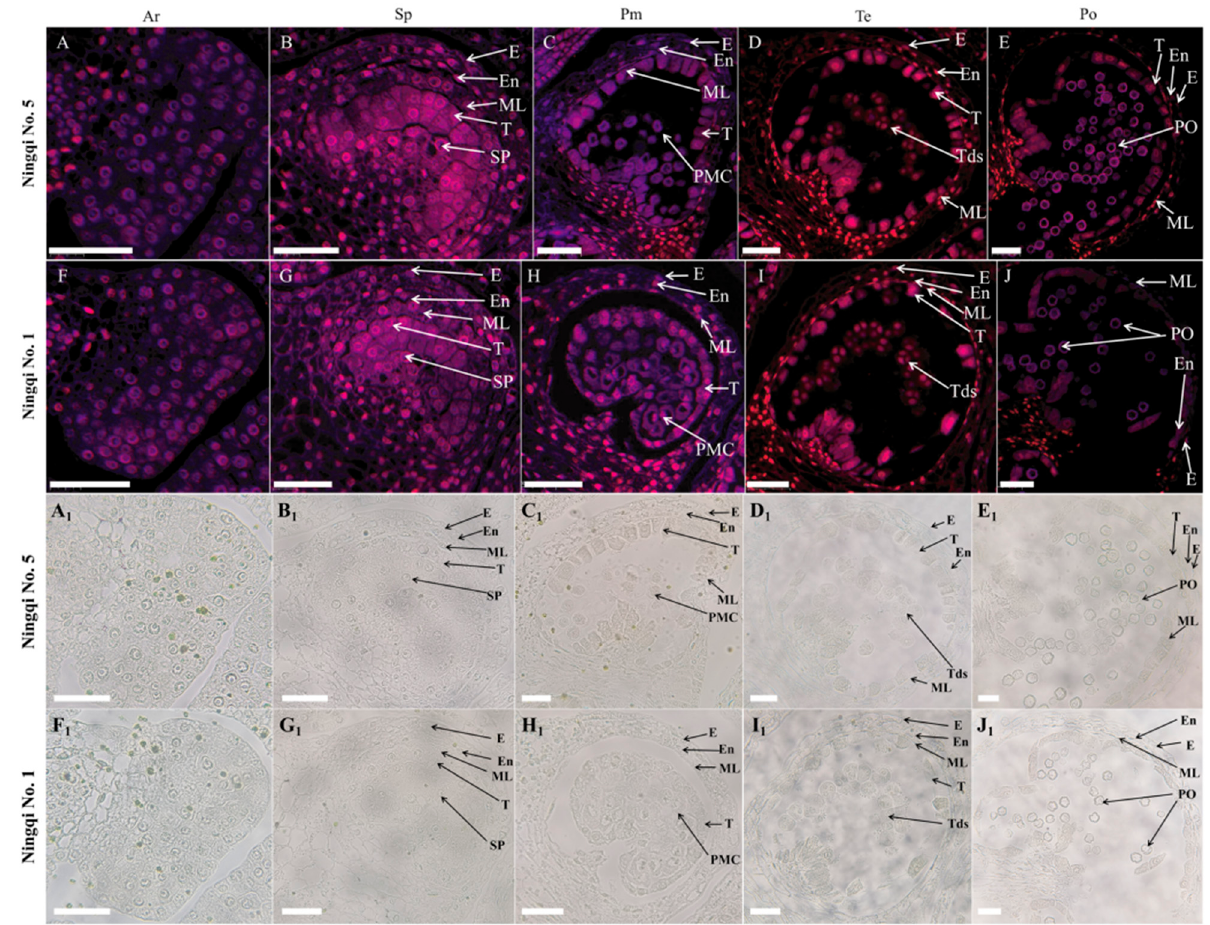
Figure 4. Apoptosis during pollen development of Ningqi No. 5 and Ningqi No. 1. ( A – E ) Pollen development of Ningqi No. 5; ( F – J ) pollen development of Ningqi No. 1; ( A 1 – E 1 ) and ( F 1 – J 1 ) are non-fluorescent photos of ( A 1 – E 1 ) and ( F 1 – J 1 ), respectively. ( A , F ) Pollen sac apoptosis at Ar stage; ( B , G ) pollen sac apoptosis at Sp stage; ( C , H ) pollen sac apoptosis at Pm stage; ( D , I ) pollen sac apoptosis at Te stage. ( E , J ) Pollen sac apoptosis at Po stage. E, epidermis; EN, endothecium; ML, middle layer; T, tapetum; Tds, tetrad; PMC, pollen mother cell; SP, sporogenous cell; Po, pollen grain. Red shows apoptosis signal. Scale bar = 50 μ m.